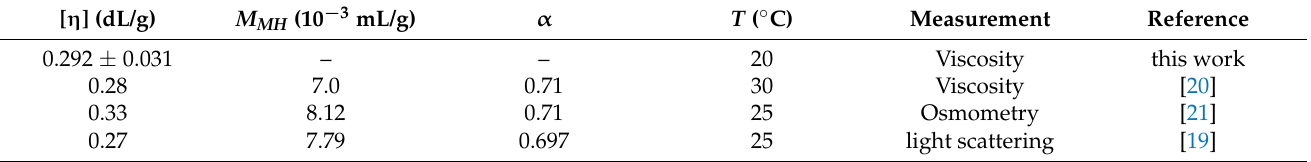
Table 1. Poly(methylmethacrylate) (PMMA) intrinsic viscosity estimated from Mark–Houwink parameters. Intrinsic viscosity estimates determined from Equation (10). Coefficients, K MH and a , were obtained from studies that utilized different analytical techniques. Presented results and referenced studies were performed at comparable temperatures. [ η ]